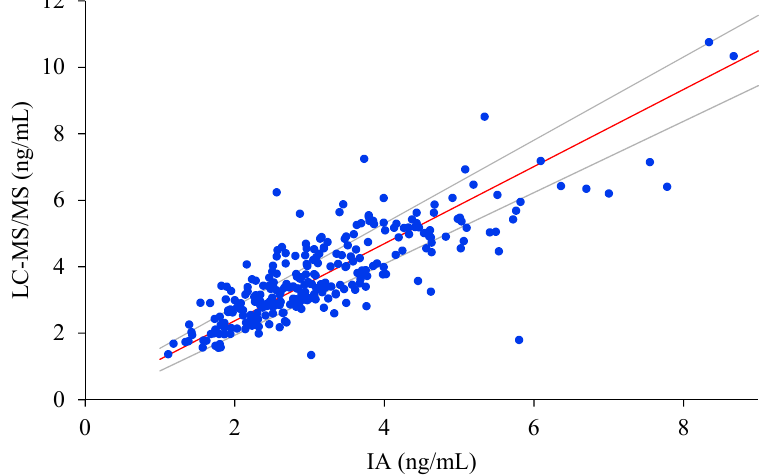
Figure 1. Passing–Bablok regression analysis for comparison between the LC-MS/MS method ( y -axis) and the IA method ( x -axis). Y = 0.0533 + 1.1603x (dark solid line).